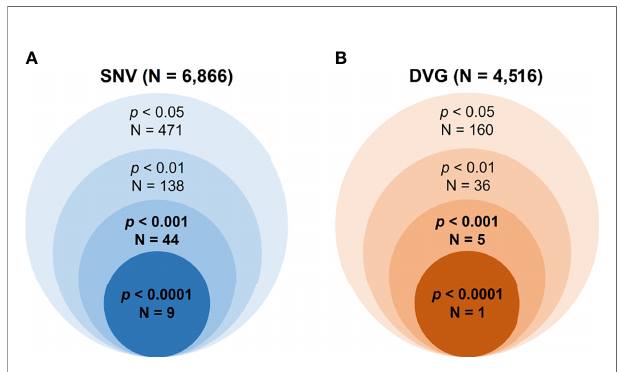
FIGURE 2 | Summary of the numbers of identi fi ed SNVs/DVGs that associated with dengue disease outcomes. The identi fi ed numbers of SNVs (A) and DVGs (B) by using different thresholds of p value with Mann – Whitney U test were summarized. A total of 6,866 SNVs and 4,516 DVGs were identi fi ed from 65 enrolled DENV-2-infected patients, respectively. In the Mann – Whitney U test results, forty-four SNVs and fi ve DVGs were observed to be highly associated with disease severity in DENV-2-infected patients, with p < 0.001, and nine SNVs and one DVG, with p <